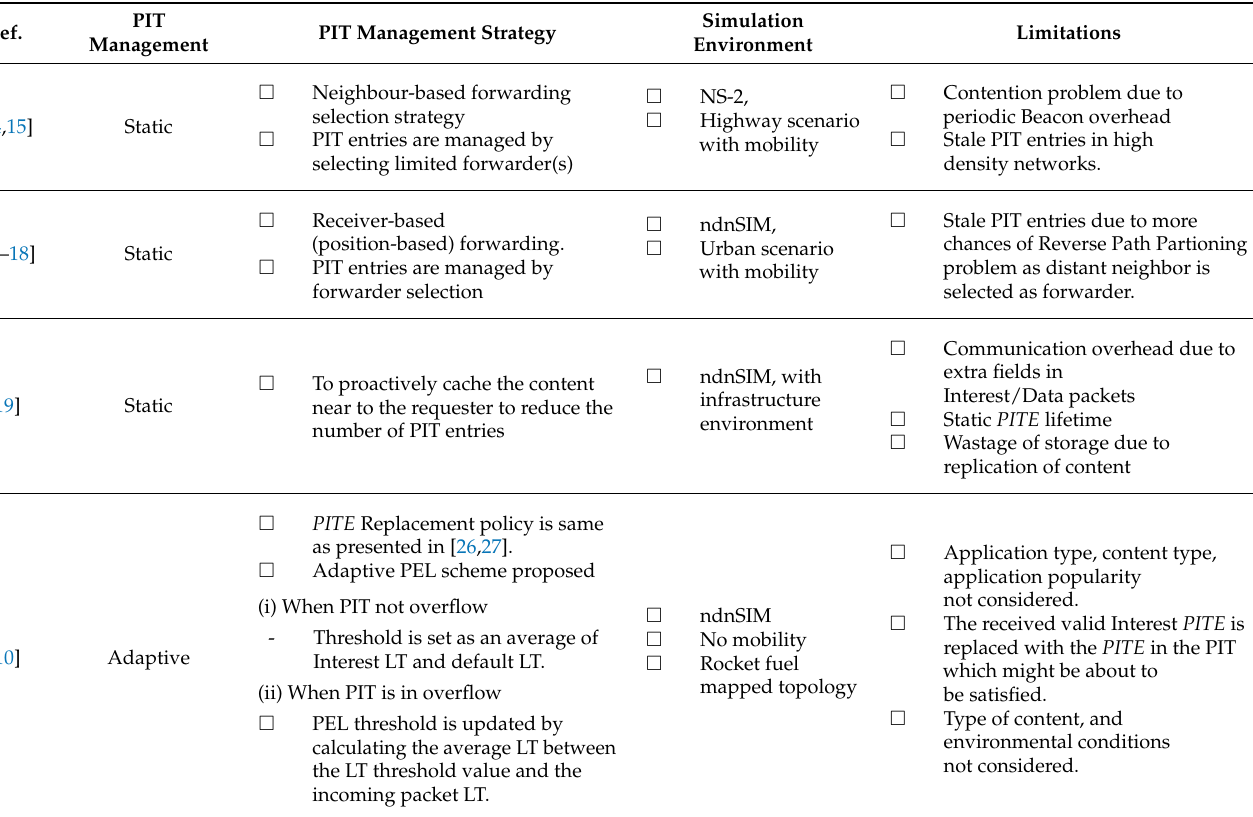
Table 1. PIT Management Schemes in NDN-based